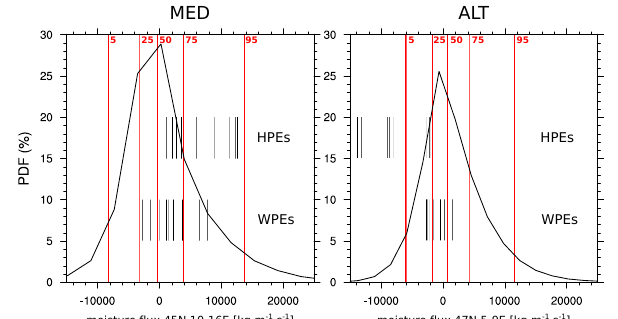
Figure 8. Difference between the minimum and maximum pressure during the entire life cycle for the HPEs (left panel) and WPEs (right panel). The events are sorted according to precipitation produced in the target area (Fig. 2), with #1 being the most extreme precipitation event. The three horizontal black lines indicate the mean and the standard deviation,